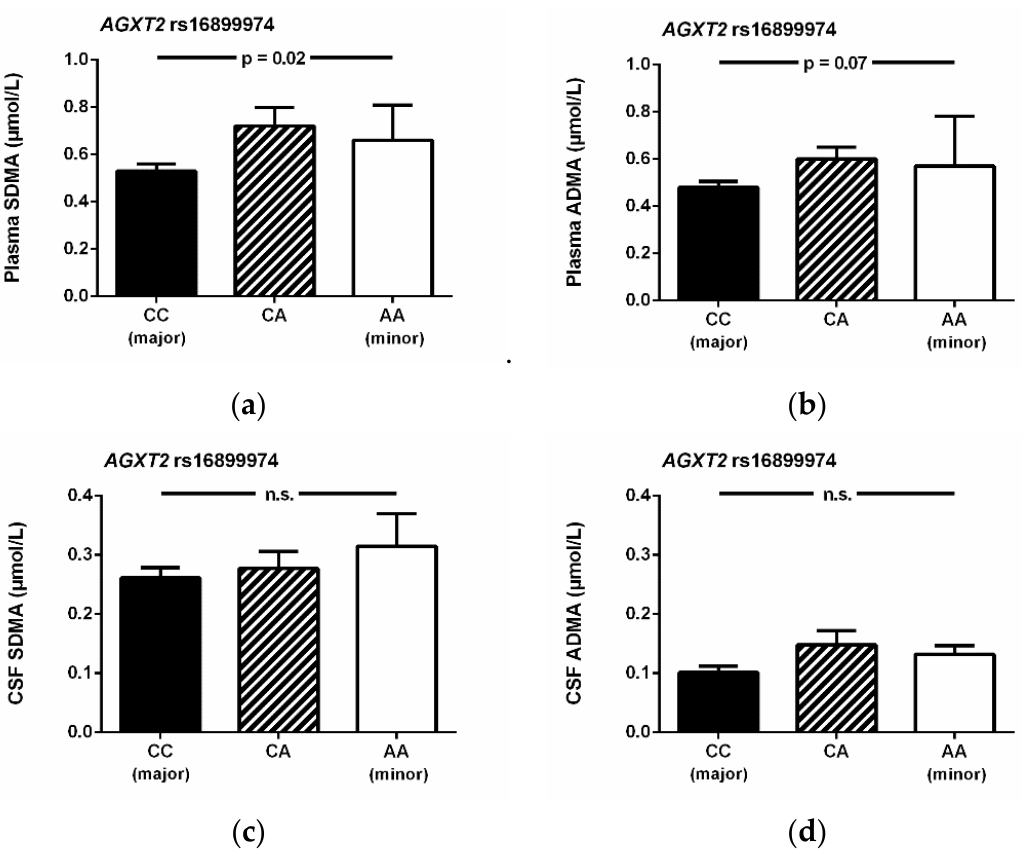
Figure 4. Plasma and CSF concentrations of SDMA ( a , c ) and ADMA ( b , d ) in relation to genotypes of the AGXT2 rs168999974 SNP. Data are mean ± S.E.M. Abbreviations: ADMA, asymmetric dimethylarginine; CSF, cerebrospinal fluid; SDMA, symmetric dimethylarginine; S.E.M., standard error of the mean; SNP, single nucleotide polymorphism.